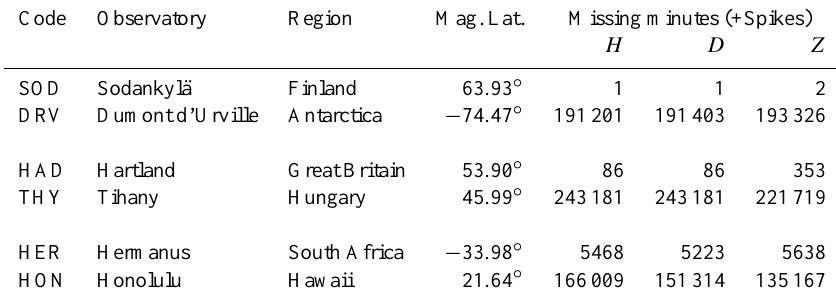
Table 1. Summary of observatories and data used, 1991–2008.